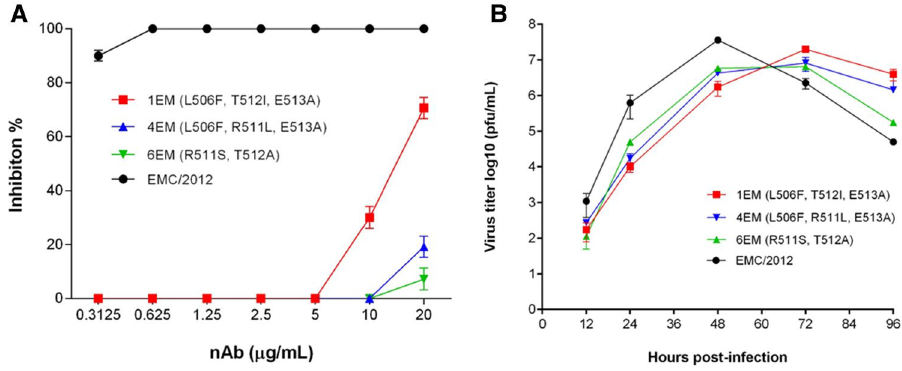
Figure 5. Characterization of MERS-CoV RBD variants generated by nAb KNIH90-F1 treatment. ( A ) Neutralization of three RBD mutants by the KNIH90-F1 neutralizing antibody was determined by plaque reduction neutralization test assay; 20 μg/ml of antibody was serially diluted twofold in PBS. ( B ) Growth kinetics of three RBD mutants. All viruses infected Vero cells at a multiplicity of infection of 0.01. Viral titers of cell culture supernatants were determined by plaque assay. EMC/2012 strain cultured without nAb was used as a control virus.